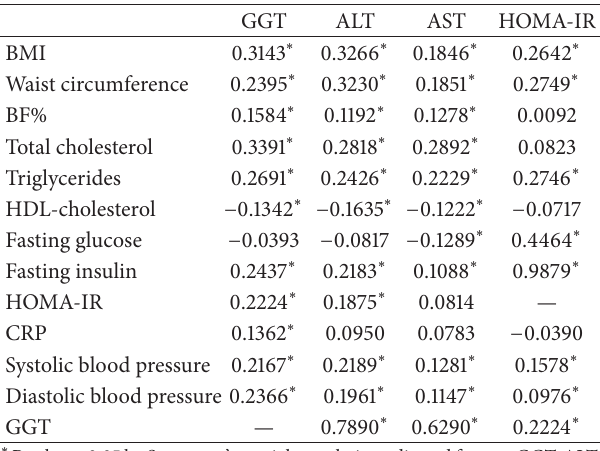
Table 2: Partial correlation of serum GGT, ALT, and AST with other variables and anthropometric variables in boys.